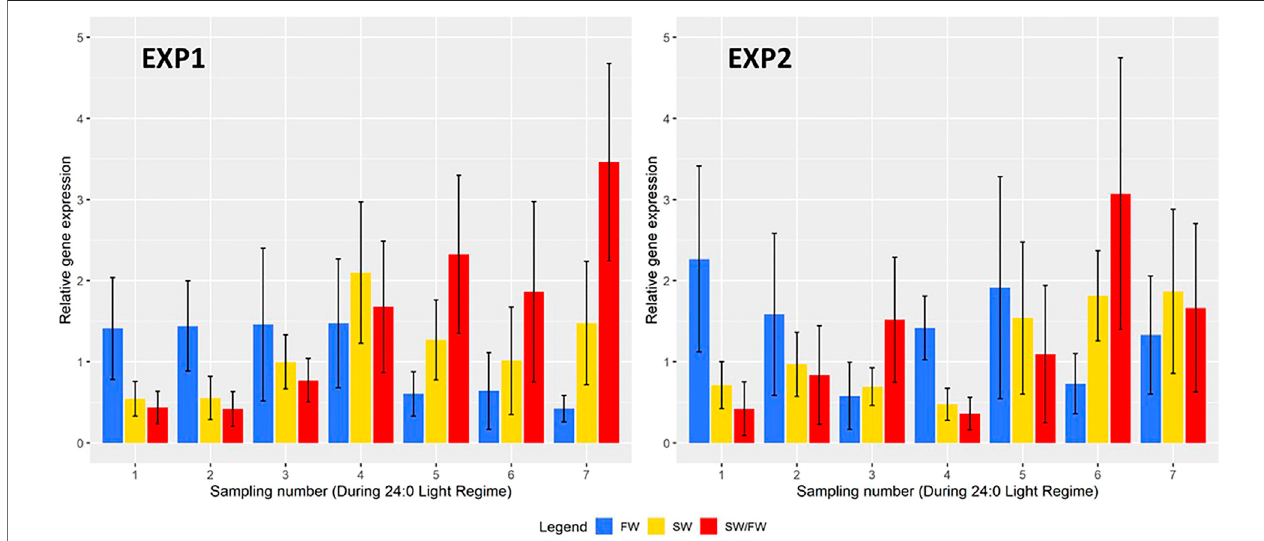
FIGURE3| Meanreal-timequantitativepolymerasechainreaction(RT-qPCR)values( ± theirstandarddeviations)oftwokeygenes{Na + K + ATPase[NKA α 1aforthe freshwater variant (FW); NKA α 1b for the saltwater variant (SW)]} with effect on Na + /K + ATPase in the gills and their ratio (SW/FW) at each sampling for EXP1 and